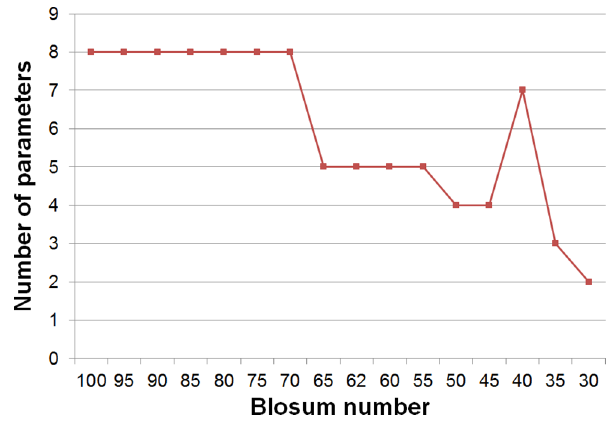
Figure 4. The optimal number of eigenvectors for reconstruc- tion of the BLOSUM matrices. The optimal number of eigenvectors was obtained with the help of the Bayesian Information Criterion.